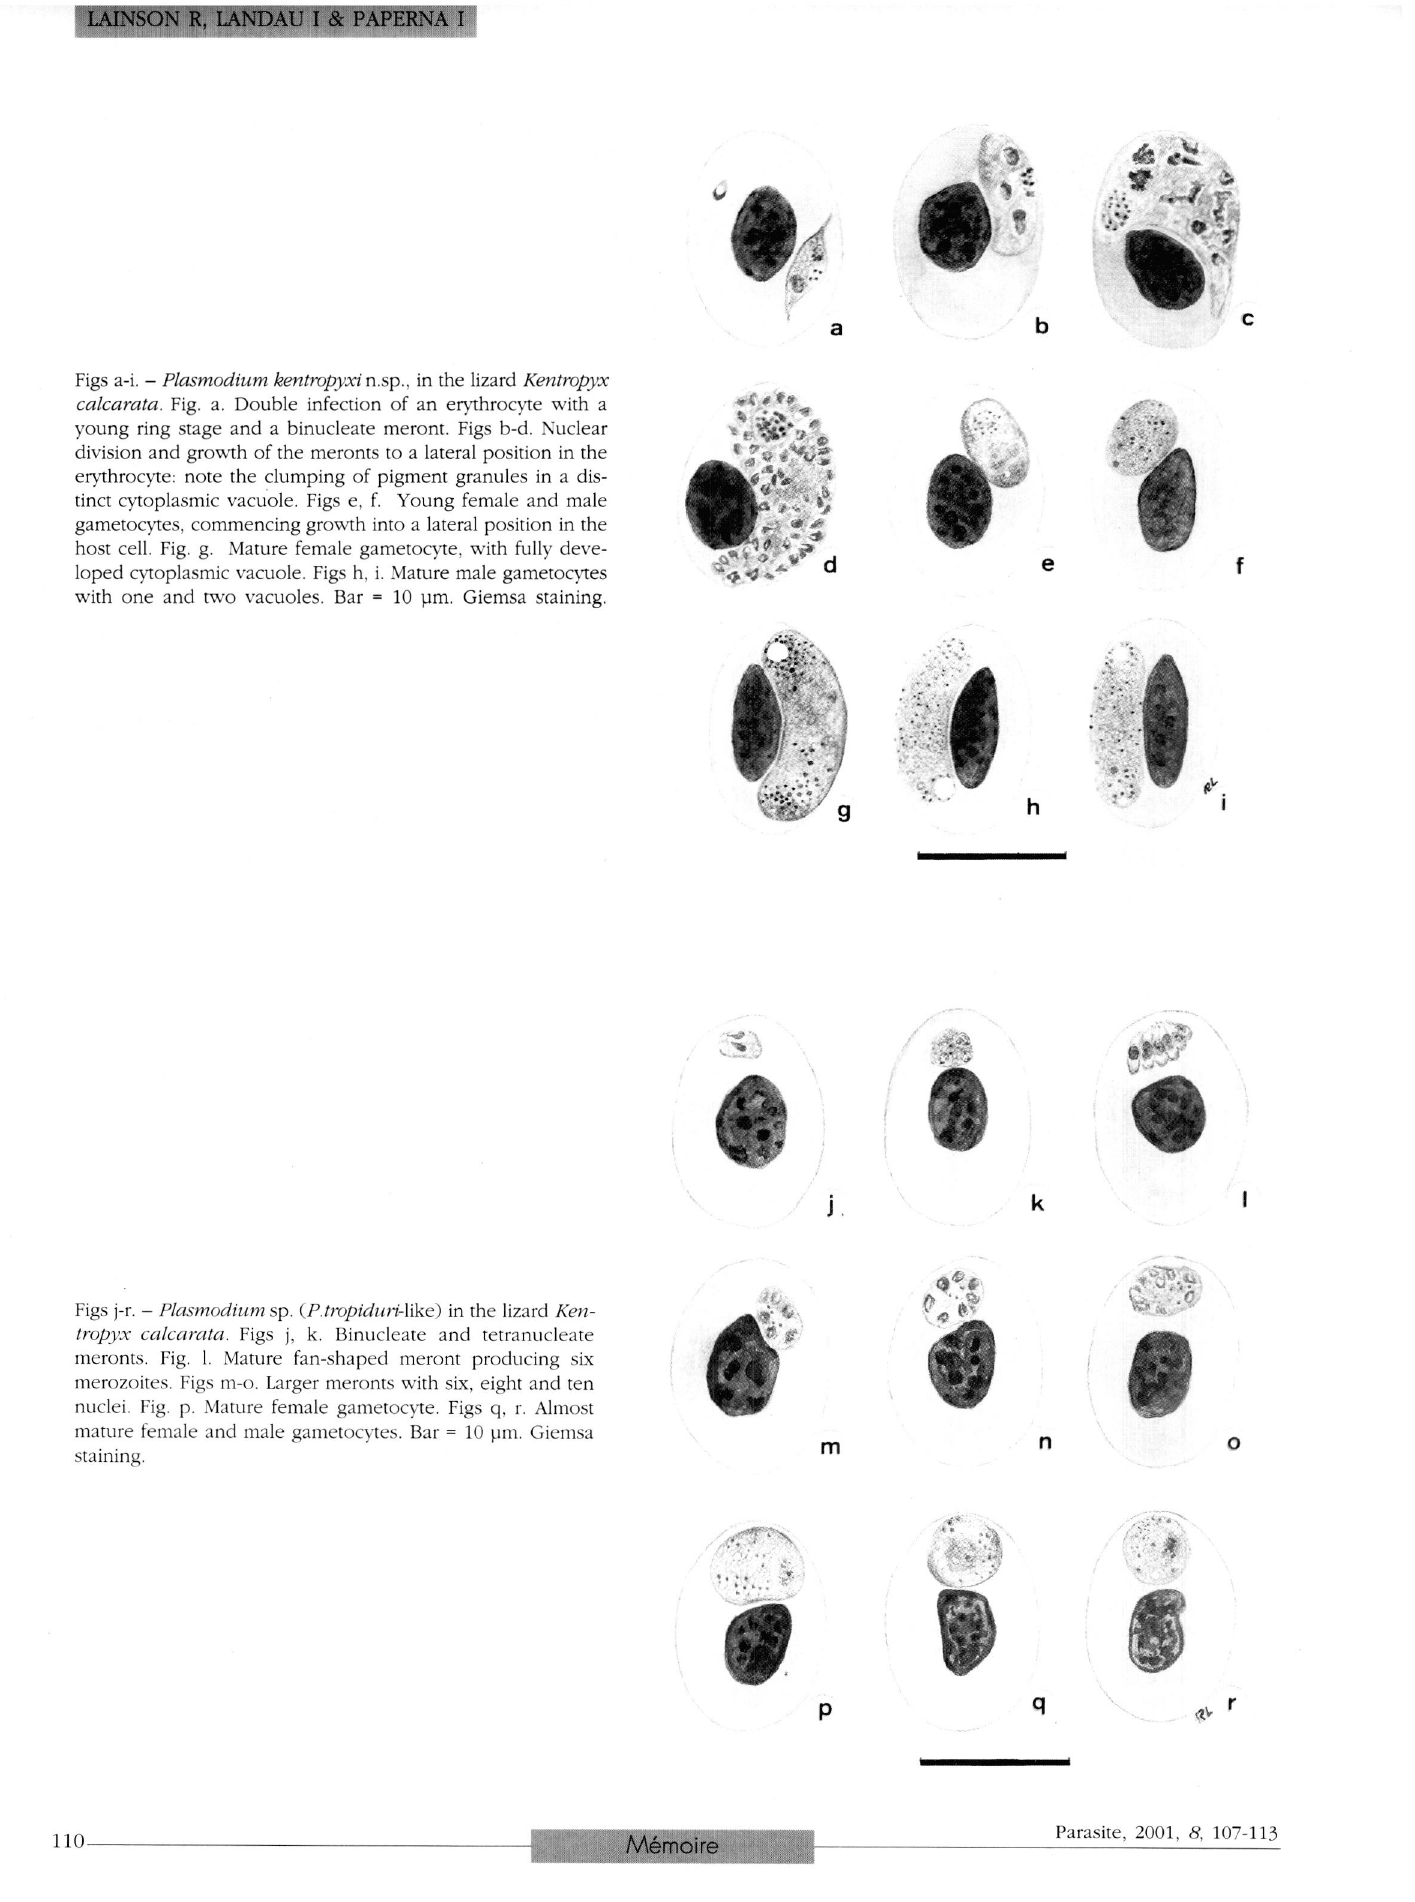
Figs j-r. - Plasmodium sp. (P.tropiduii-Wke) in the lizard Ken­ tropyx calcarata. Figs j, k. Binucleate and tetranucleate meronts. Fig. 1. Mature fan-shaped meront producing six merozoites. Figs m-o. Larger meronts with six, eight and ten nuclei. Fig. p. Mature female gametocyte. Figs q, r. Almost mature female and male gametocytes. Bar = 10 um. Giemsa